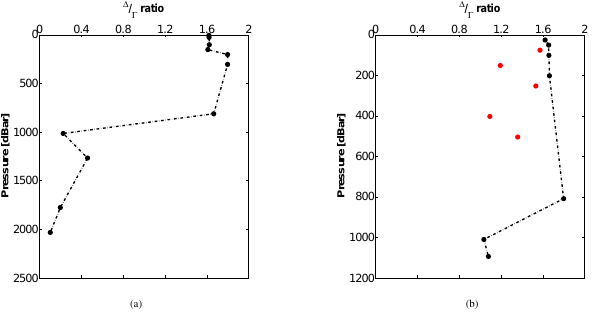
Figure 12. Determined 1 / 0 ratios (a) in the Sea of Crete at sta- Fig. 12: Determined ∆ / Γ ratios, ( a ) in the Cretan Sea at station 288 and ( b ) in the Adriatic Sea at station 313 obtained by thetransienttracercoupleCFC-12andSF 6 .Thereddotsin( b )indicateratioswithameanagedifference > 5 yearsandthus tion 288 and (b) in the Adriatic Sea at station 313 obtained by the definedasnon-constrainedwithintheIG-TTDmodel. transient tracer couple CFC-12 and SF 6 . The red dots in (b) indi- cate ratios with a mean age difference > 5 years and thus defined as non-constrained within the IG-TTD